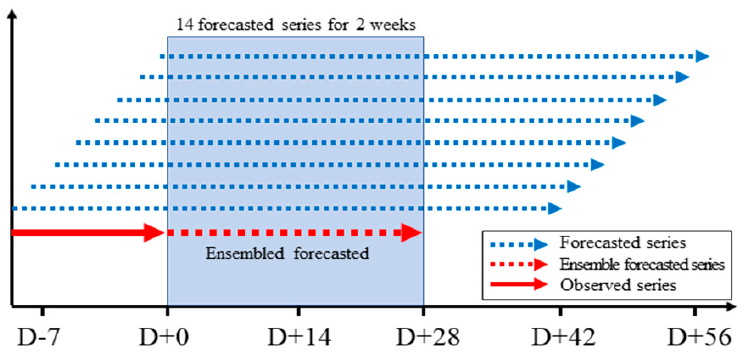
Figure 6. Concept diagram of attractor-concept ensemble forecasting.